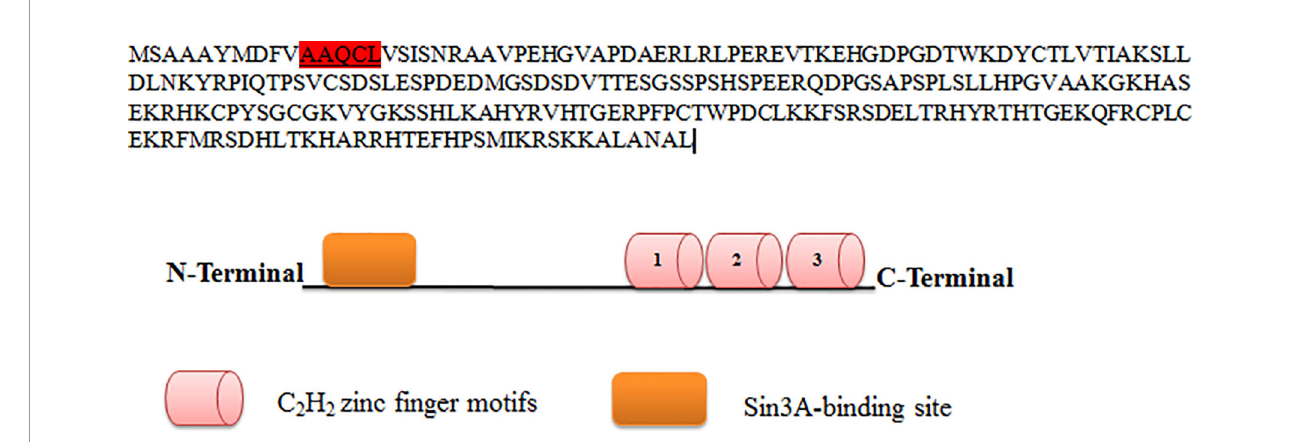
FIGURE 3 | Protein sequence of KLF9 . KLF9 is highly homologous to other members of the Kruppel-like factor (KLF) family at carboxy-terminal DNA-binding regions, which contain three C 2 H 2 zinc fi nger motifs. At the N-terminal region is the Sin3A binding